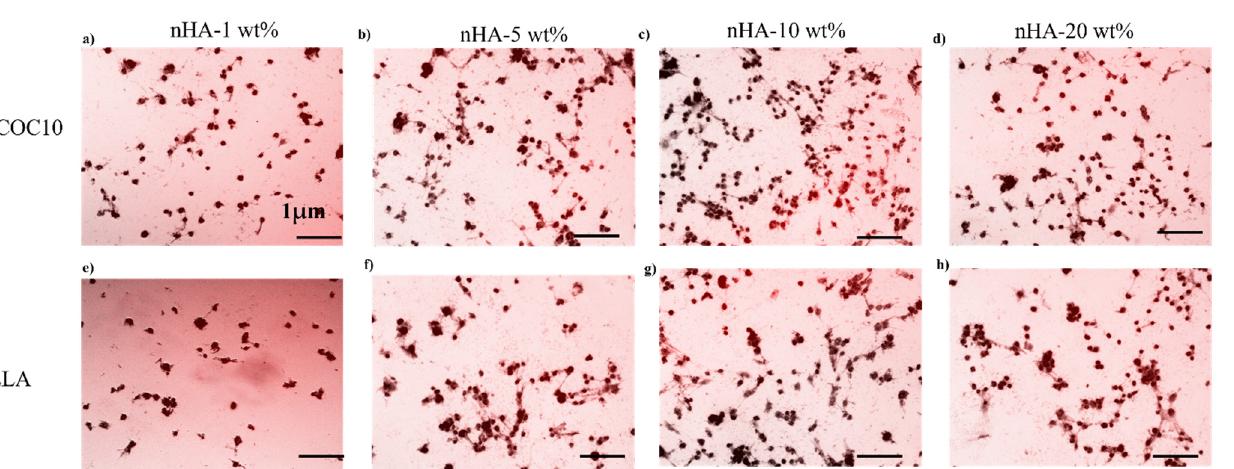
Figure 13. Alizarin red S staining was used to analyze the mineralization of BMSC for PLLA/COC10-